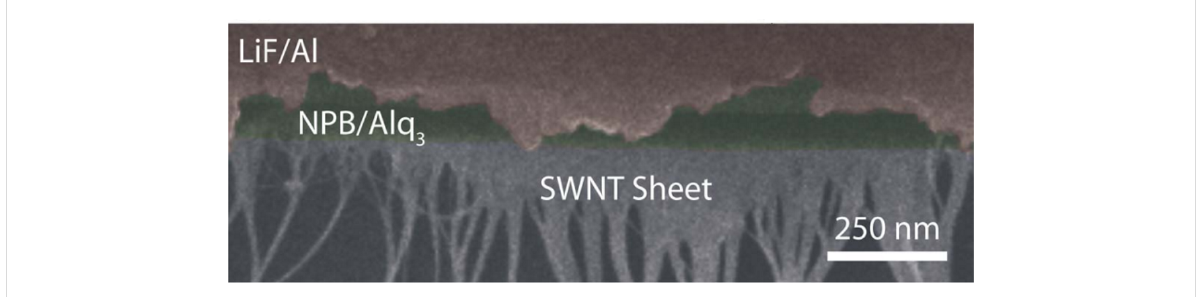
Figure 2: Cross-sectional scanning electron microscopy (SEM) image of the layers of the OLED. The various layers in the device are clearly visible including the vertical SWNT sheet. Figure 2 was adapted from [21], with the permission of AIP Publishing. This content is not subject to CC BY 4.0.